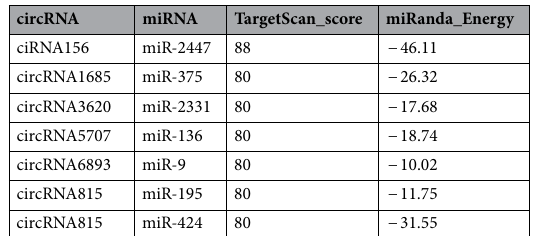
Table 4. Interaction versus between circRNA–miRNA. Table shows that the num of TargetScan fractional percentiles ≥ 80, − 50 < the num of Miranda maximum free energy values < − 10.